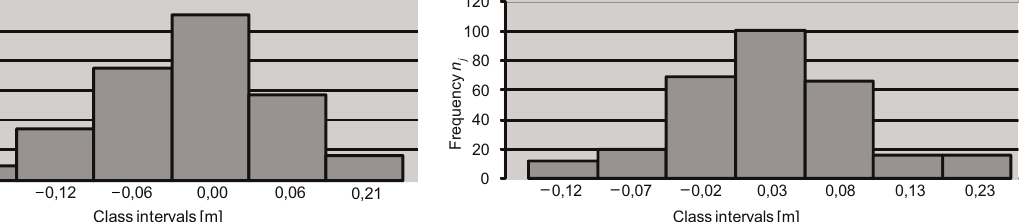
Fig. 3. Frequency distribution histogram for the X-axis coordinate deviations (Přívoz cad. district)